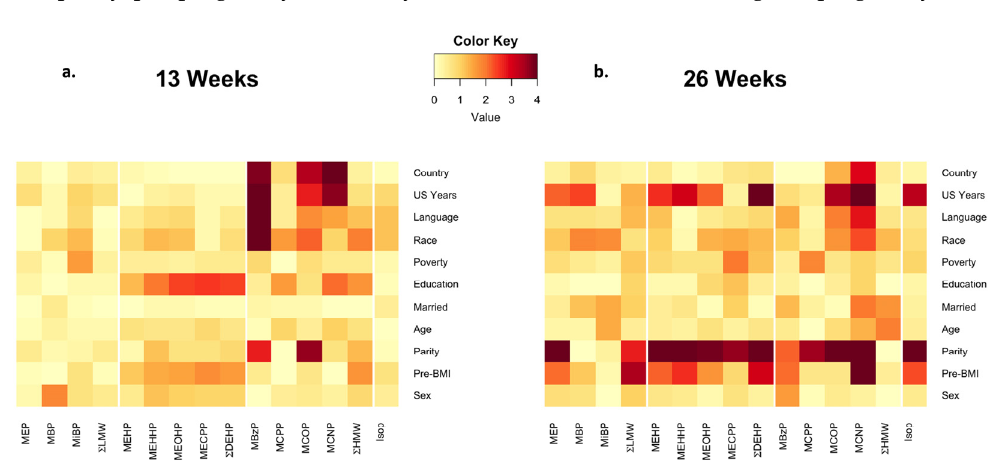
Figure 3. Heatmap of the relationship between phthalate metabolite concentrations and demographic variables at ( a ) 13 and ( b ) 26 weeks gestation. Each colored square represents the − log10 p ‐ value for the association of demographic variables (using the same categories as Table 1) with phthalate metabolites concentrations as determined by analysis of variance (ANOVA). The darker squares represent associations with smaller p ‐ values, with dark red representing the most significant associations ( p ~ 1 × 10 − 4 ). Each model is adjusted for creatinine by including it as a covariate.